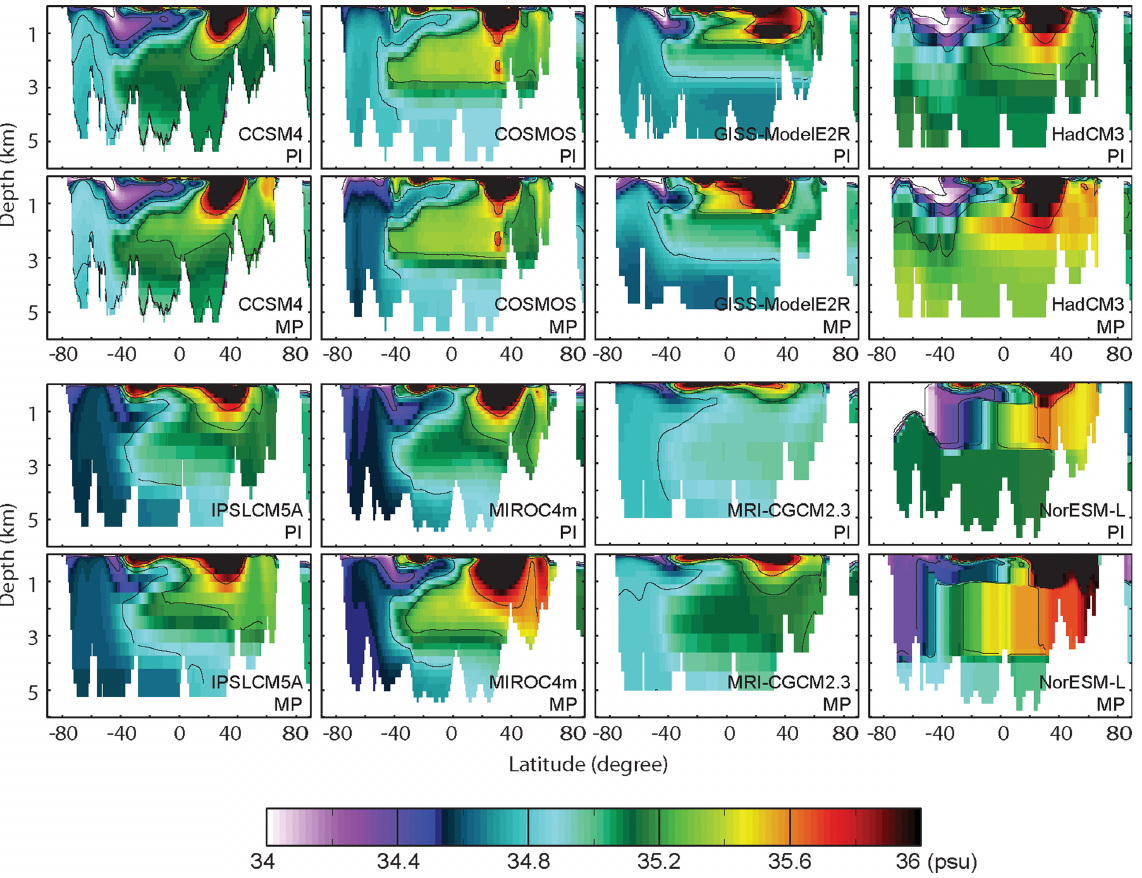
Fig. 5. Comparsion of pre-industrial (PI) and mid-Pliocene (MP) salinity (psu) profiles at 30 ◦ W simulated in the PlioMIP. The interval of the black contour is